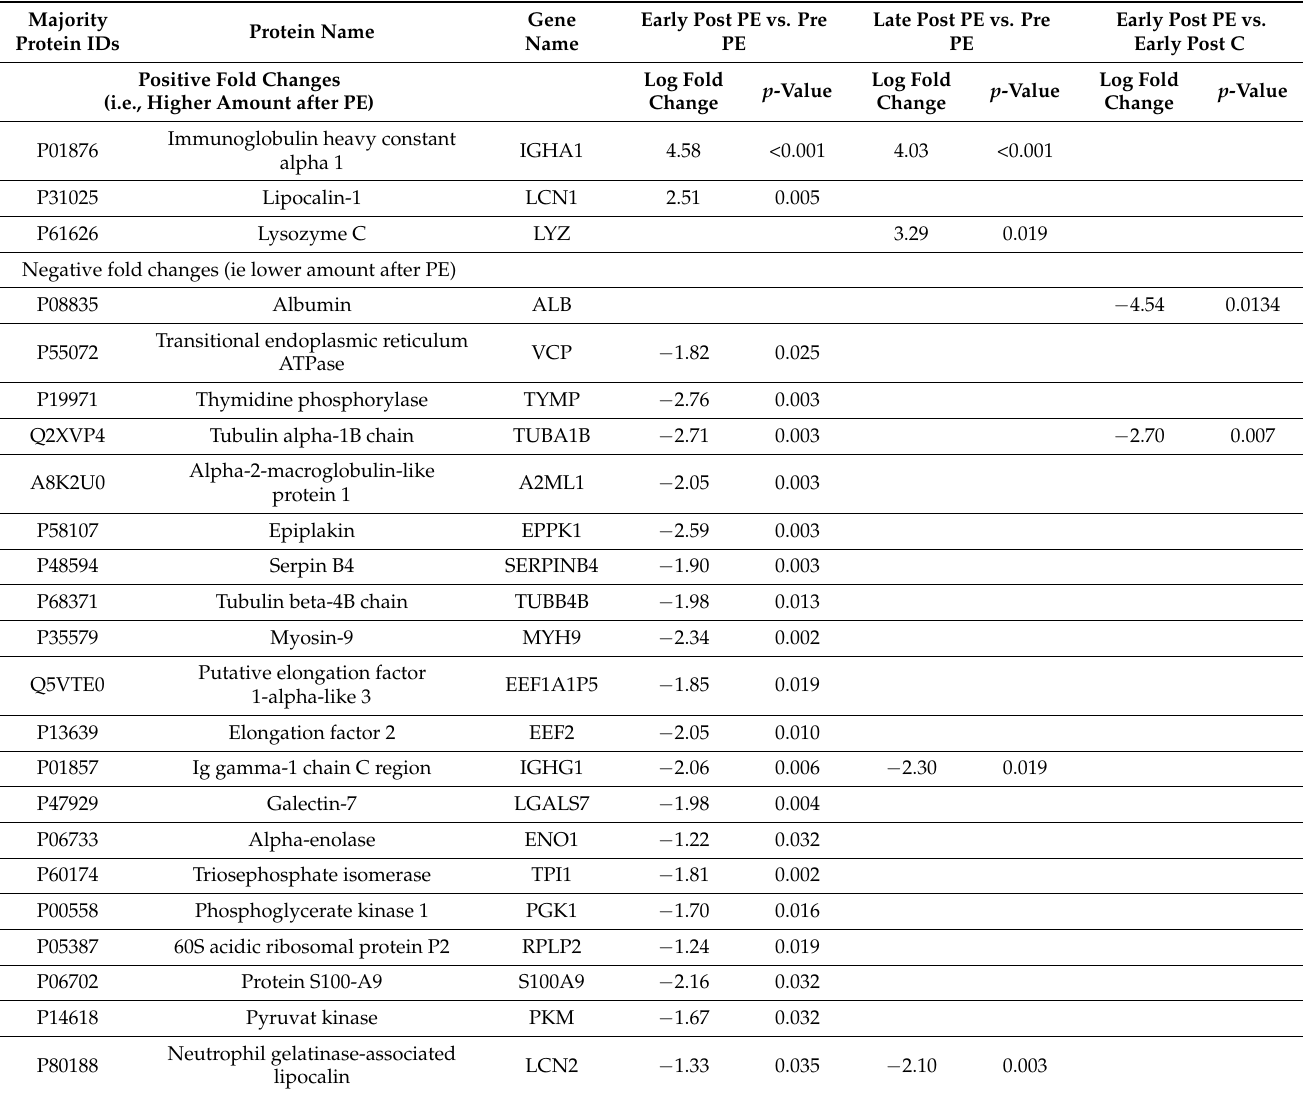
Table 2. Differential expression analysis based on 91 proteins with imputation of missing values and adjusted for multi- ple